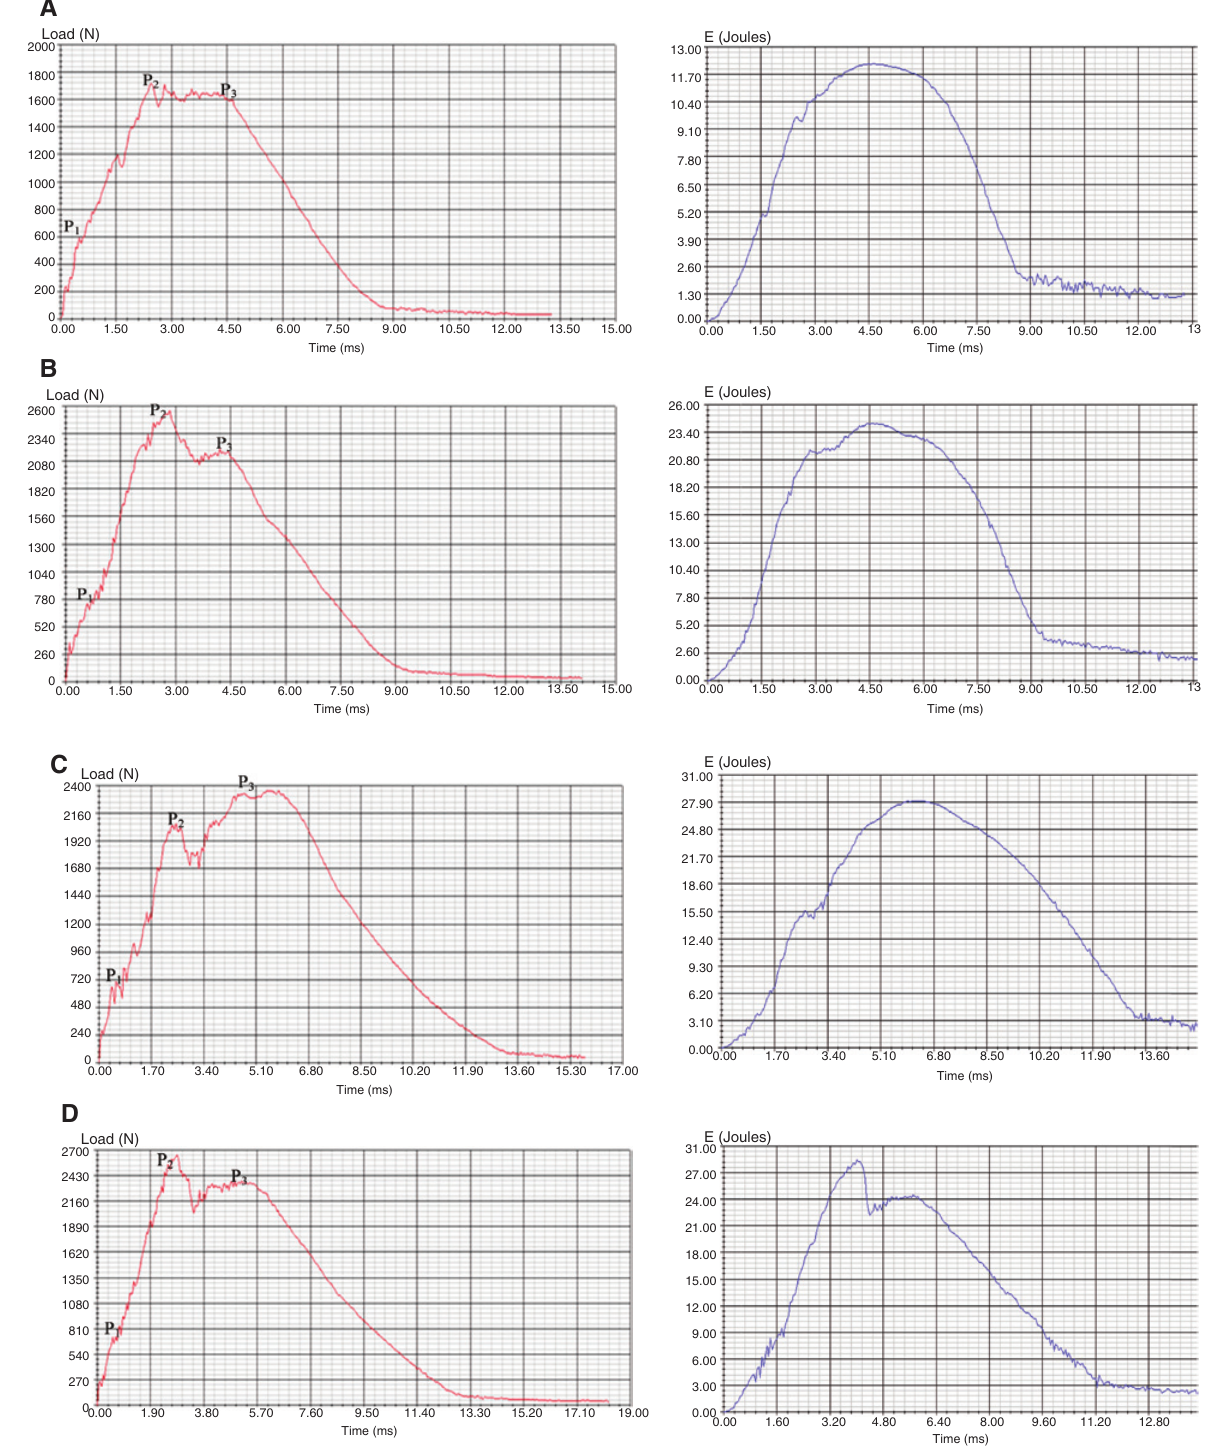
Figure 7 Load-time and energy-time plot for C25 panel at different impact energy levels. (A) Impact energy -12.64 J, (B) impact energy -25.27 J, (C) impact energy -37.64 J, (D) impact energy -50.19 J. upon the ease of manufacture and testing requirements, core is 0.2 mm and the height of the core is fixed at 8 mm. as stipulated by the relevant standards. The fabricated The thickness of the top and bottom face sheets has been test panels are shown in Figure kept constant at 1 mm. The cell sizes were selected based